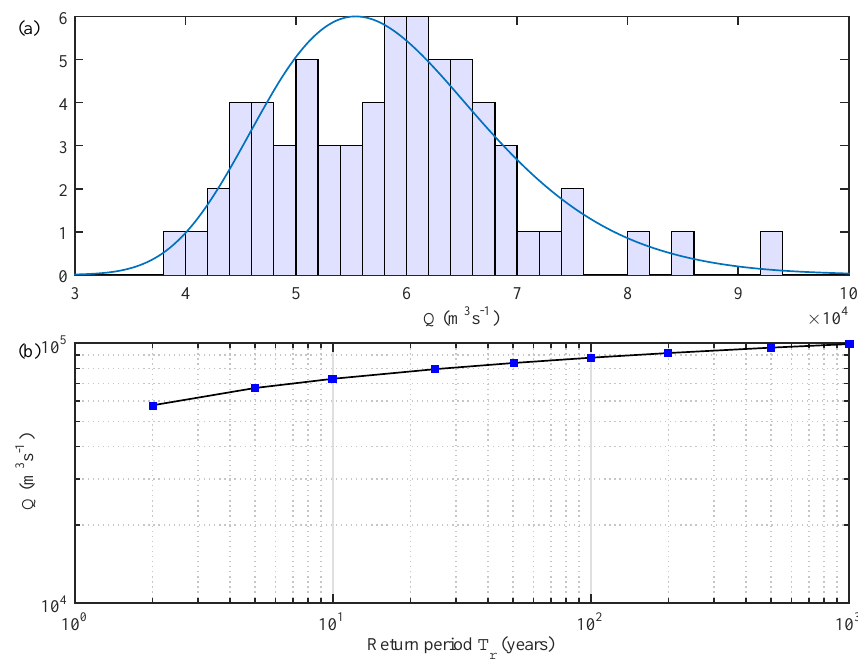
Figure 14. The fitted GEV distribution against observed maximum mean daily discharge (a) and the likelihood of peak discharges as a function of return period (b) at Datong